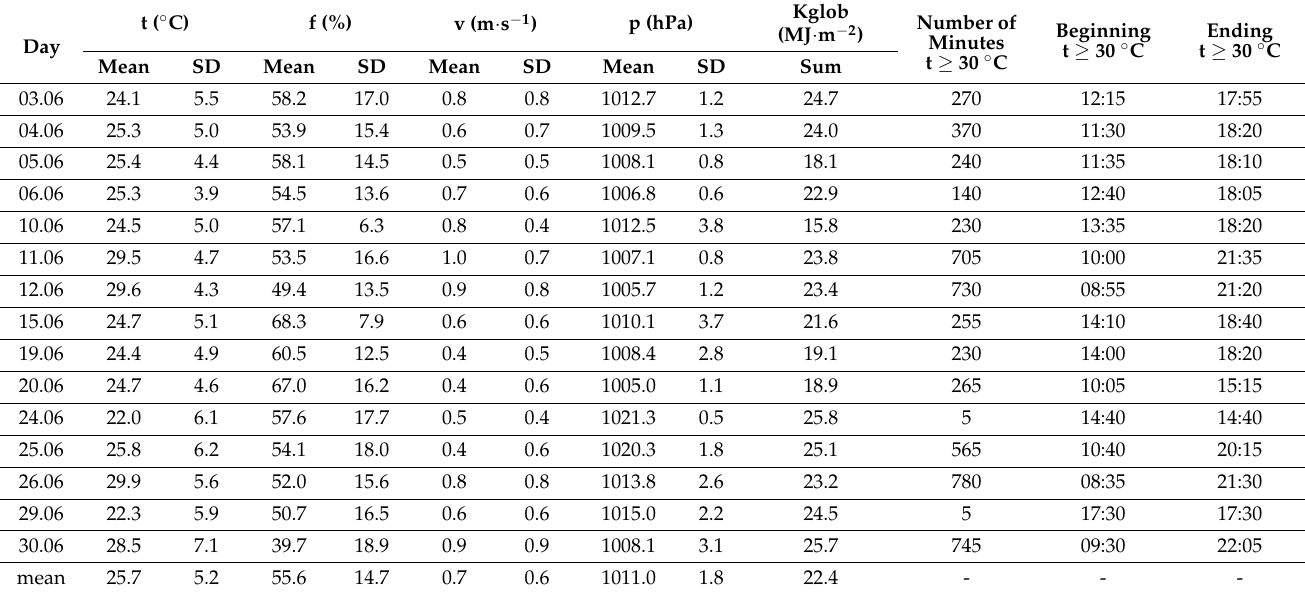
Table 4. Values and standard deviation: air temperature, relative humidity, wind speed, atmospheric pressure, and total diurnal solar irradiance, duration in minutes, and time of temperature rise above 30.0 ◦ C measured in Bydgoszcz on hot days in June